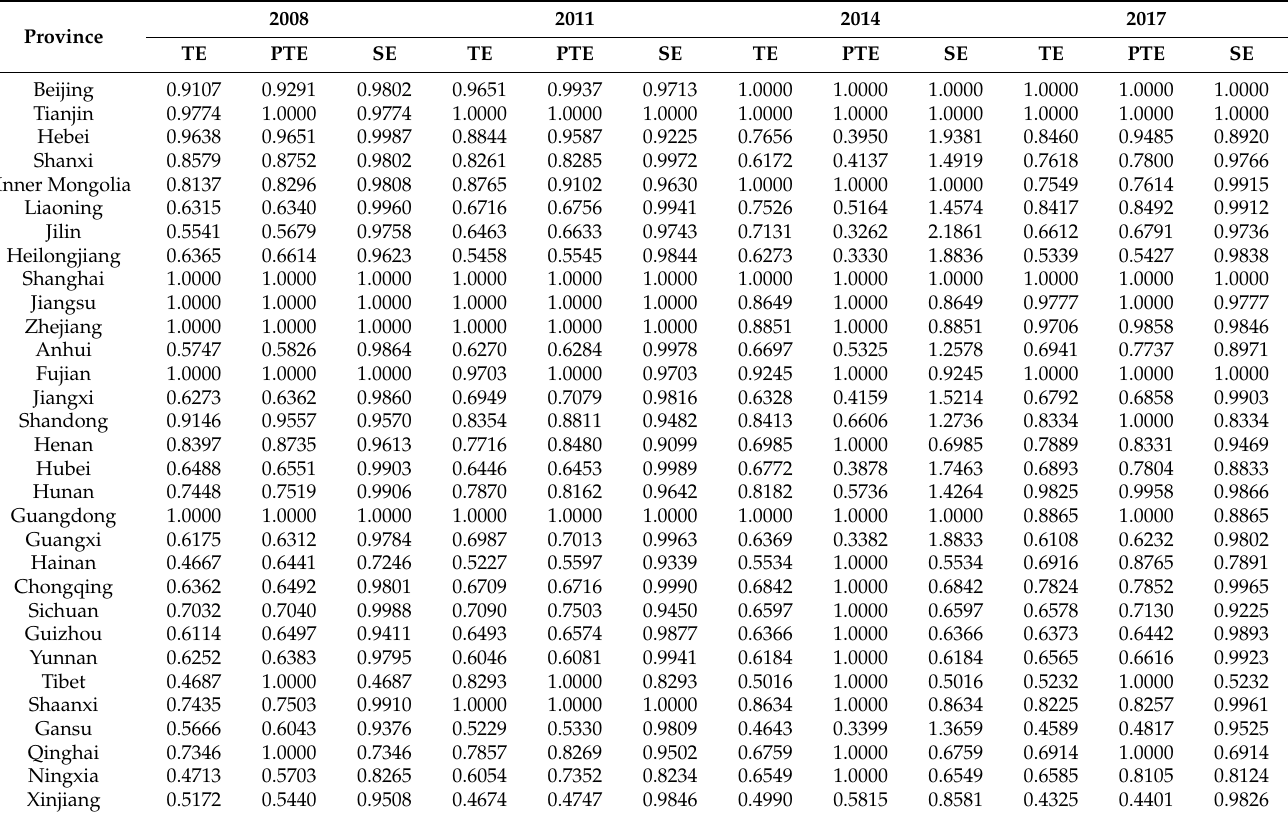
Table 3. Decomposition of provincial urban land use efficiency in